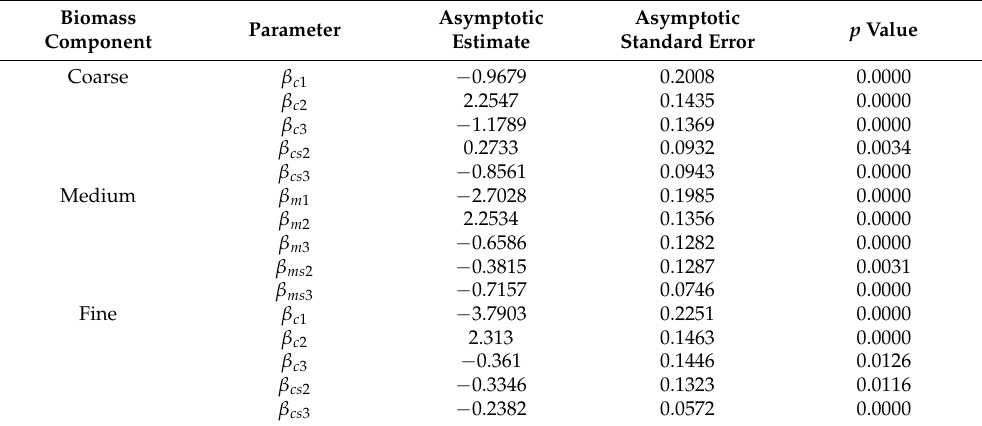
Table 5. Parameter estimates and their asymptotic standard errors and p values for the additive root biomass equation